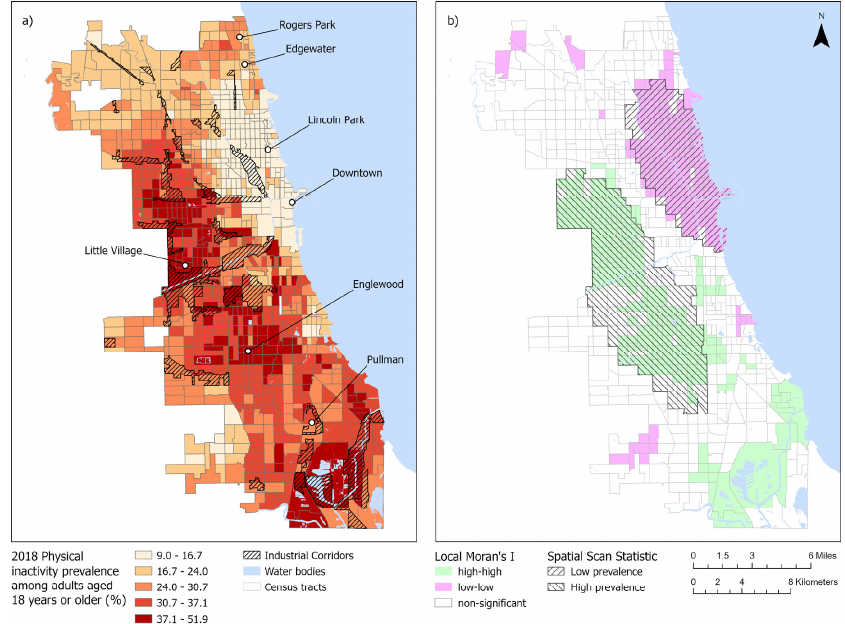
Figure 1. ( a ) Choropleth map of physical inactivity; ( b ) Local Moran I and spatial scan